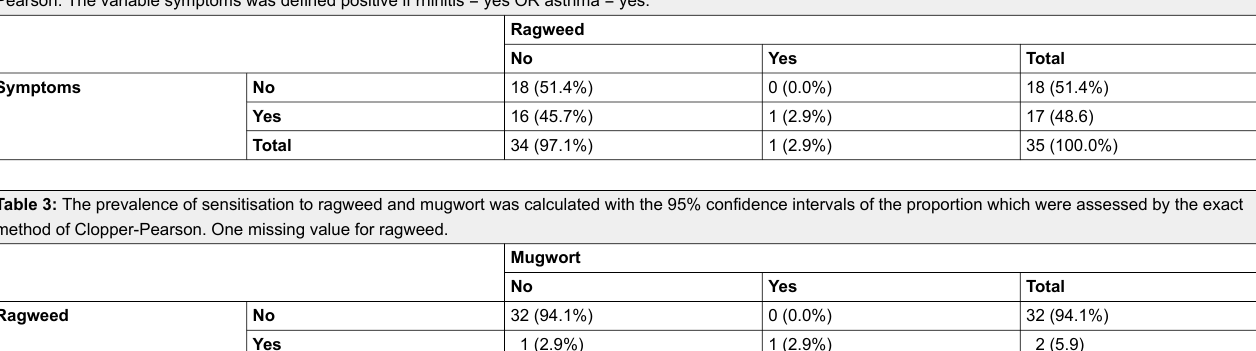
Table 2: The prevalence of allergy to ragweed was calculated with the 95% confidence intervals of the proportion which were assessed by the exact method of Clopper- Pearson. The variable symptoms was defined positive if rhinitis = yes OR asthma = yes. Ragweed